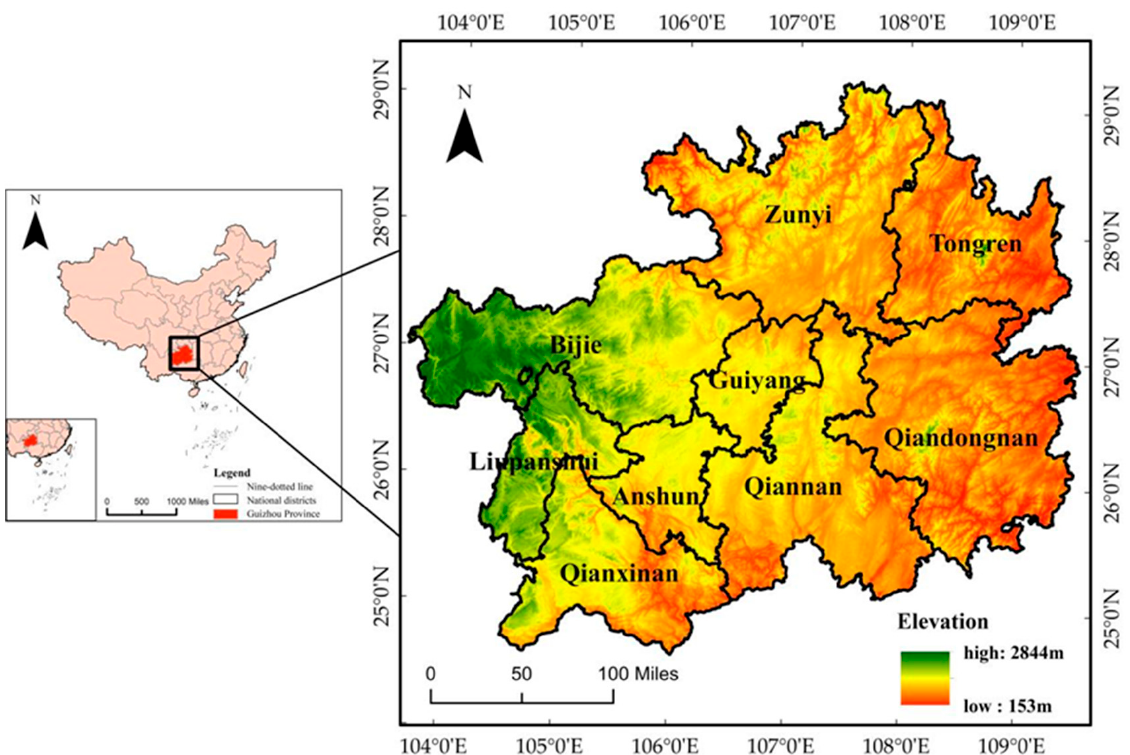
Figure 2. Location and altitude of Guizhou in 2020.